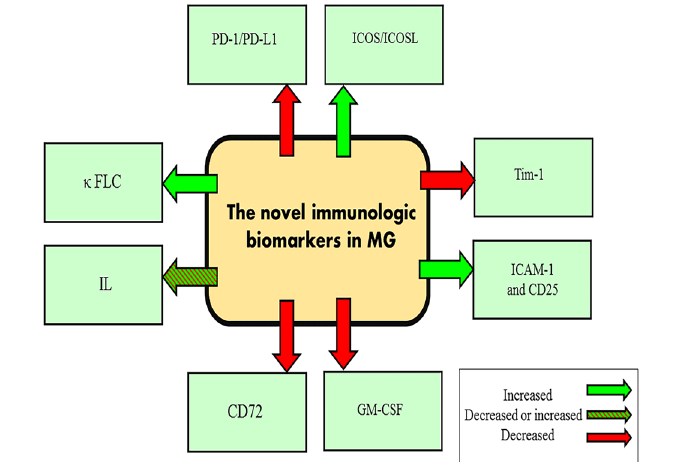
Figure 1. The novel immunologic biomarkers in